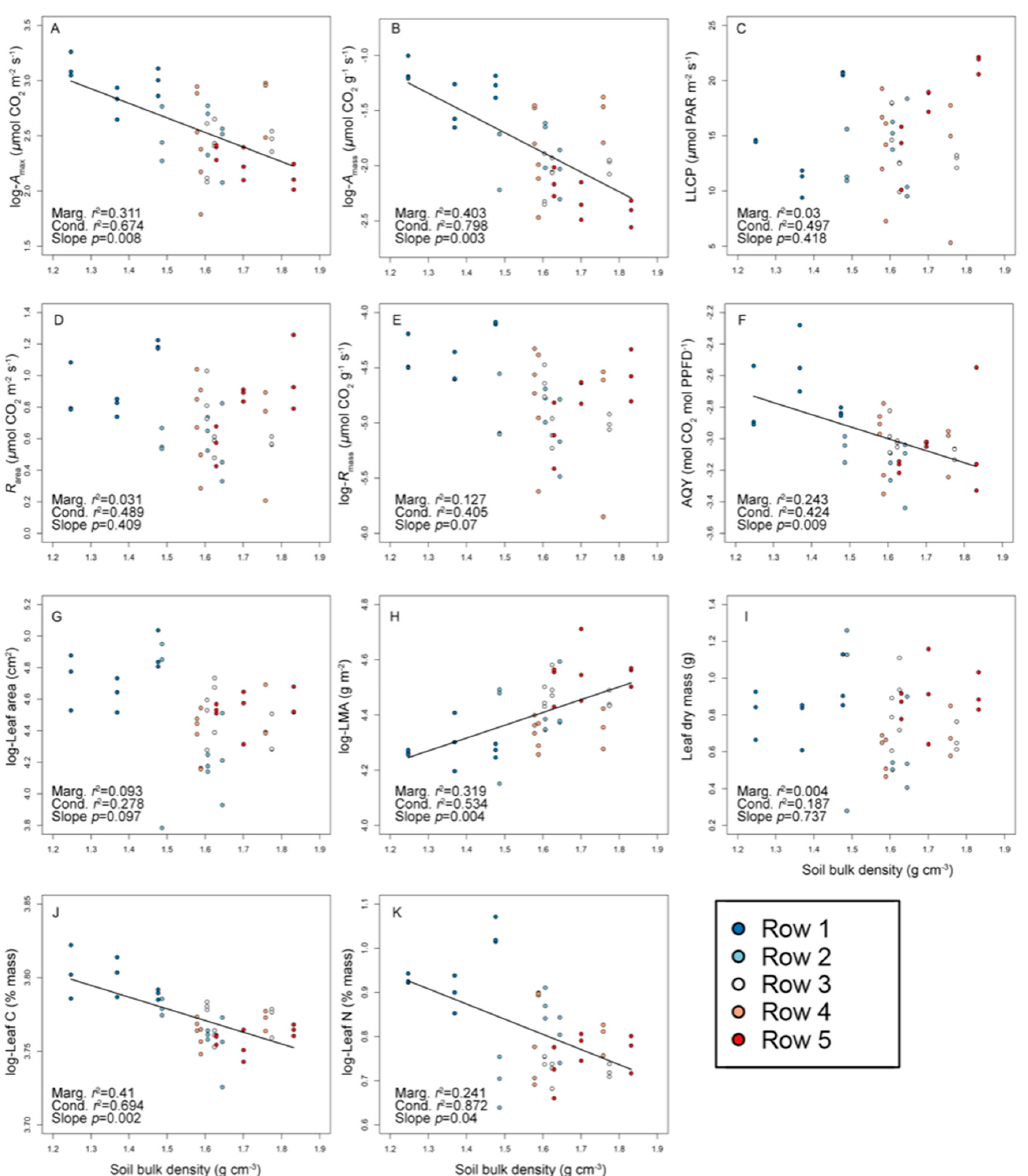
Figure 1. Relationships between 11 ‘Chardonnay’ leaf traits and soil bulk density. Relationships are presented for: light-saturated maximum photosynthetic rate on a per leaf area basis ( A max , Panel A ); light-saturated maximum photosynthetic rate on a per leaf mass basis ( A mass , Panel B ); leaf-level light compensation point (LLCP, Panel C ); leaf respiration rate on a per leaf area basis ( R area , Panel D ); leaf respiration rate on a per leaf mass basis ( R mass , Panel E ); apparent quantum yield (AQY, Panel F ); leaf area (Panel G ); leaf mass per unit area (LMA, Panel H ); lead dry mass (Panel I ), leaf carbon (C) concentration (Panel J ); and leaf nitrogen (N) concentration (Panel K ). Trend lines correspond to statistically significant relationships (where p ≤ 0.05 for the slope parameter) between each trait and bulk density, based on linear mixed effects models predicting traits as a function of soil bulk density (as a fixed factor) while accounting for plant identity (as a random factor; see Table S2 for full model diagnostics and fits). Also presented are marginal r 2 values (“Marg. r 2 ”) for each relationship, which represents the proportion of variation in a given trait explained by fixed factors alone (i.e., bulk density and model intercept), and condition r 2 values (“Cond. r 2 ”), which represent the proportion of trait variation explained by fixed and random factors. Sample sizes for all models were 45 leaves, measured across 15 individual vines. Log-transformed trait values were used in models according to results presented in Table 1, and trait acronyms are presented in Table 1.